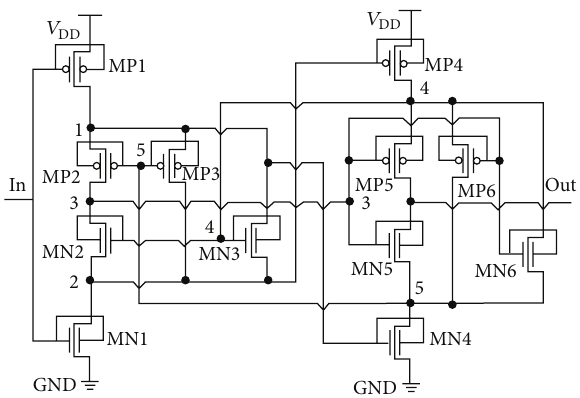
Figure 4: FinFET based realization of the proposed buffered delay model.